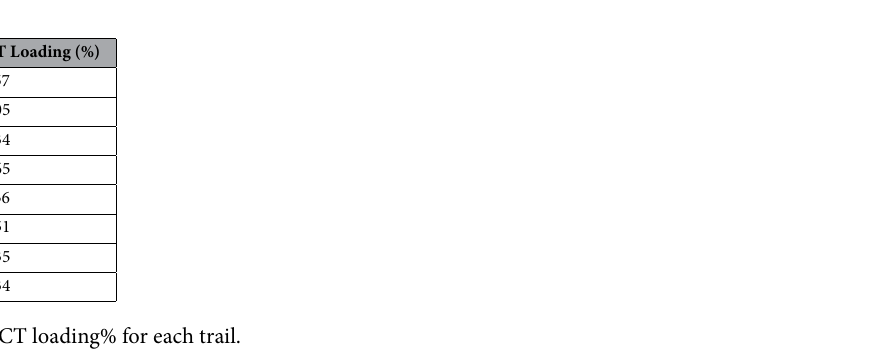
Table 2. PCT loading% for each